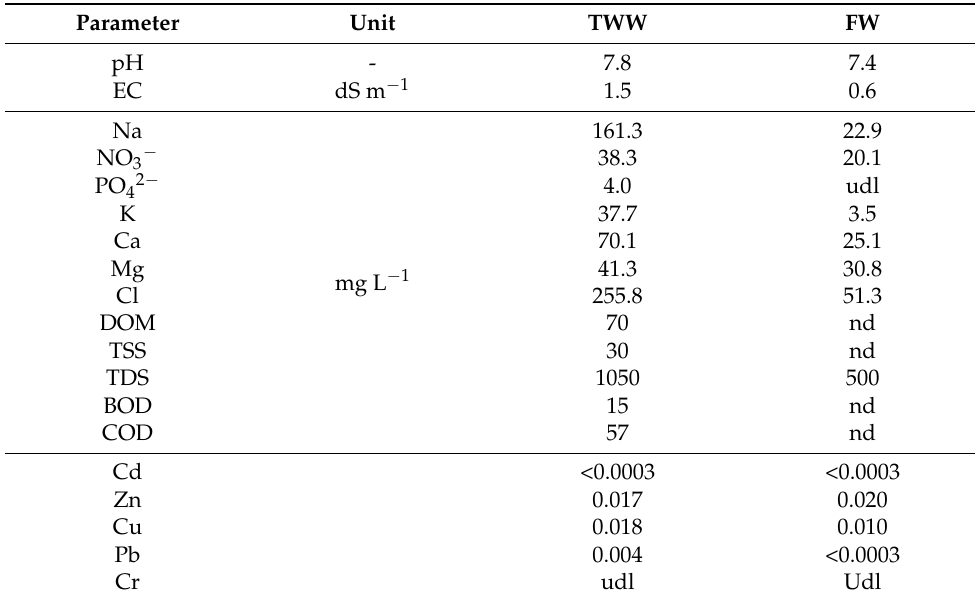
Table 1. Mean values of selected properties of the used TWW and FW.